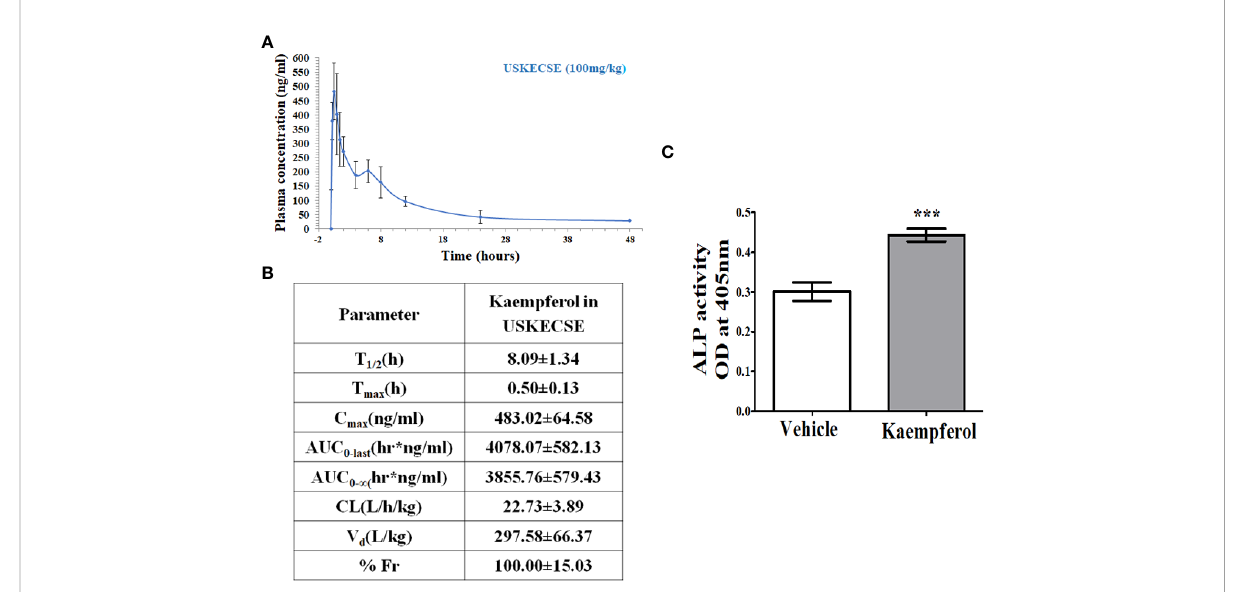
FIGURE 8 Kaempferol has oral bioavailability and an osteogenic effect upon USKECSE treatment. (A) Time-concentration pro fi le of kaempferol in plasma after a single oral dose (100 mg/kg) of USKECSE in adult female rats. (B) Table showing calculated pharmacokinetic parameters. (C) Rat calvarial osteoblasts (RCO) were treated with 2 µM kaempferol, and differentiation was assessed by alkaline phosphatase (ALP) assay. Values are expressed as mean ± SEM; *** p <.001 vs.